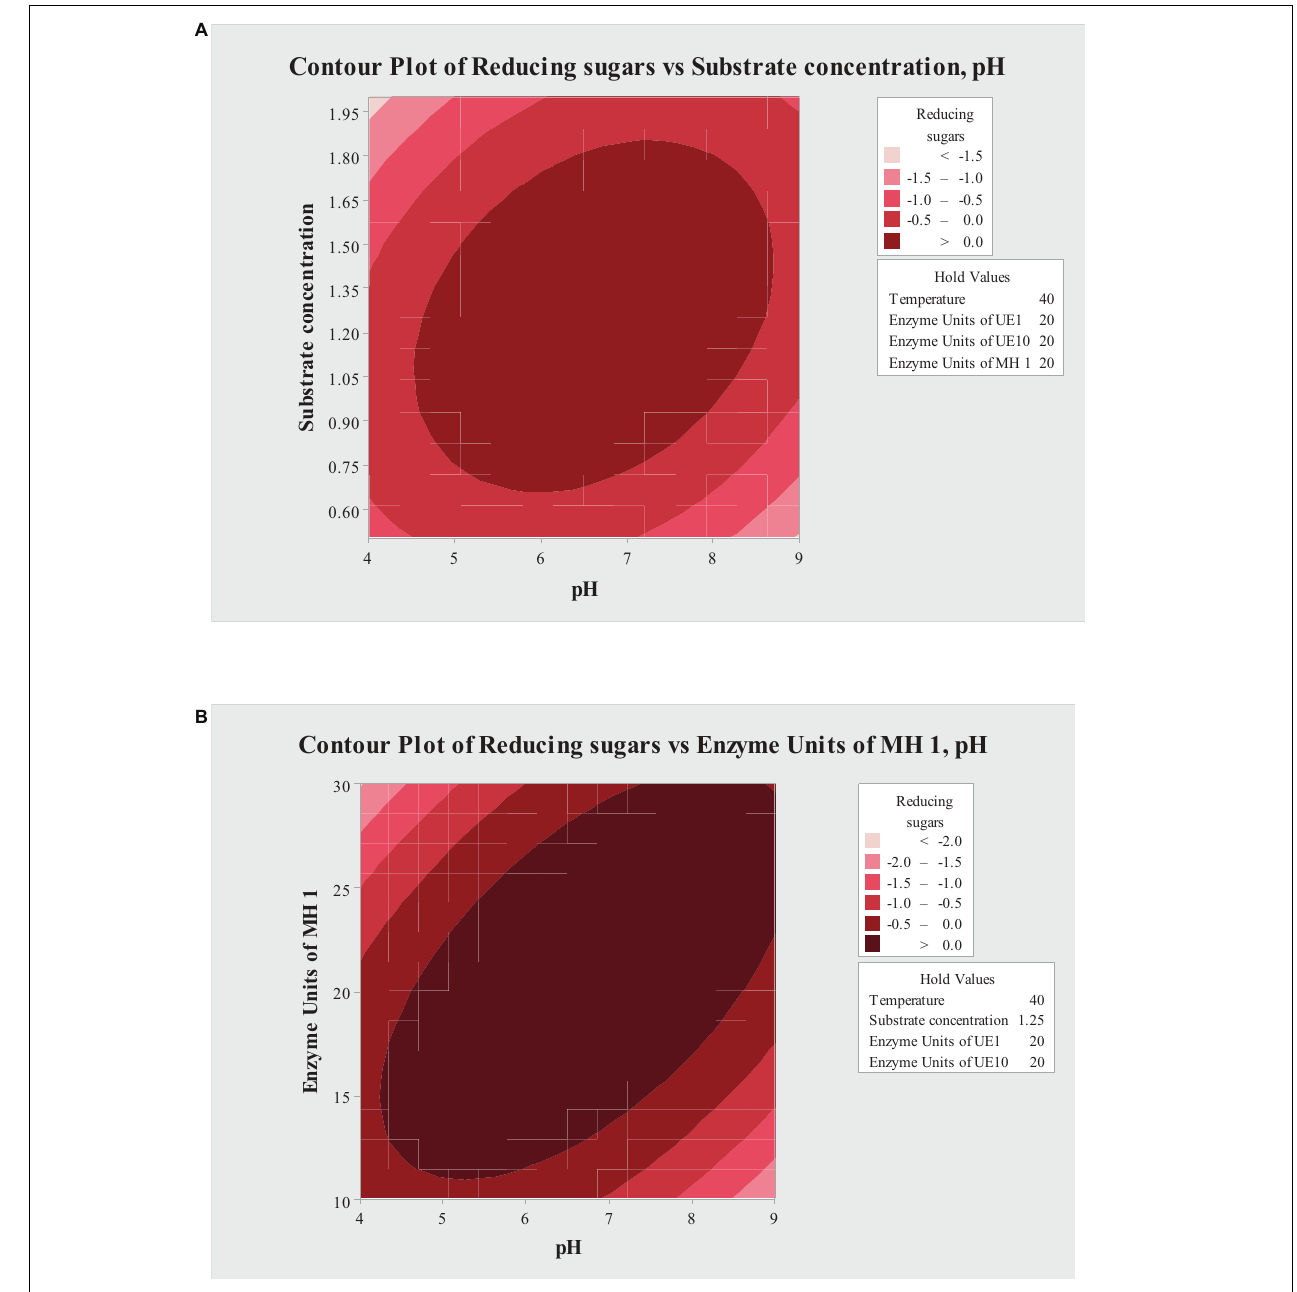
FIGURE 2 | Contour plots showing interaction of (A) pH and substrate concentration and (B) pH and enzyme units of MH 1.